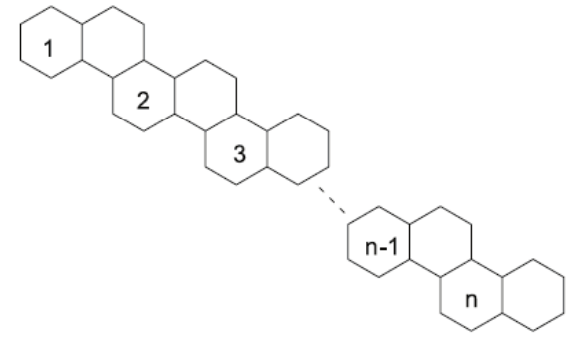
Figure 2: Graph of zigzag benzenoid system n Z